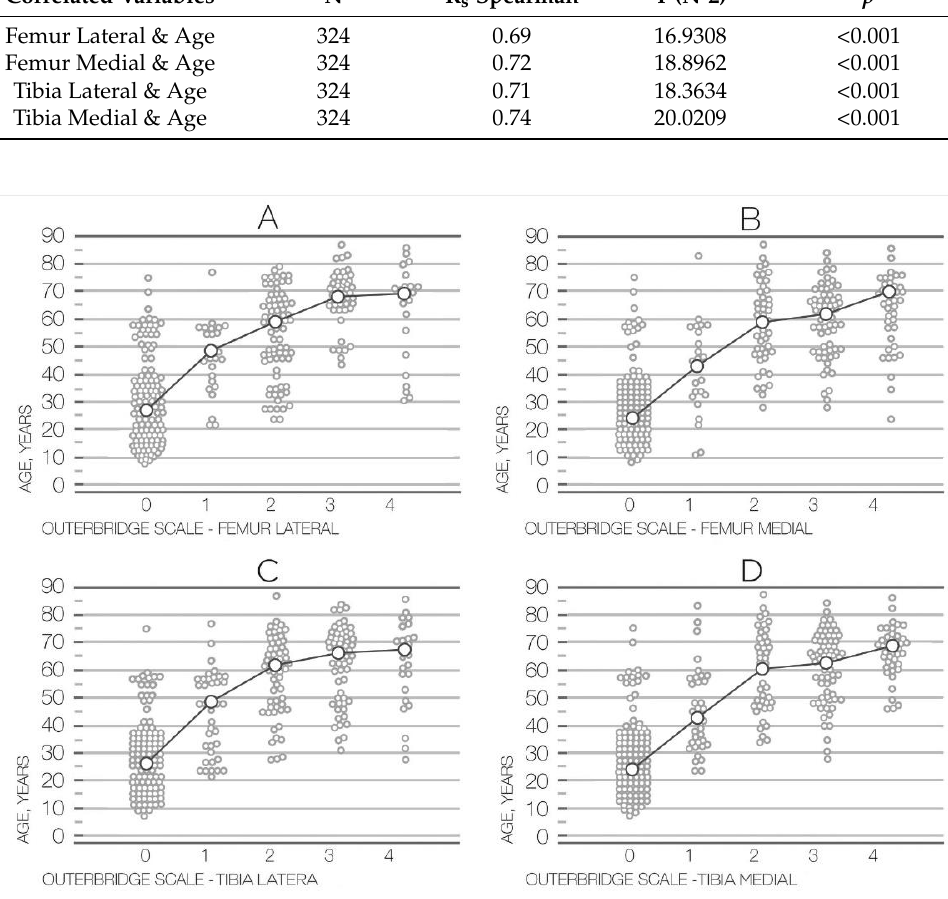
Table 3. BMI for Outerbridge scale . Outerbridge